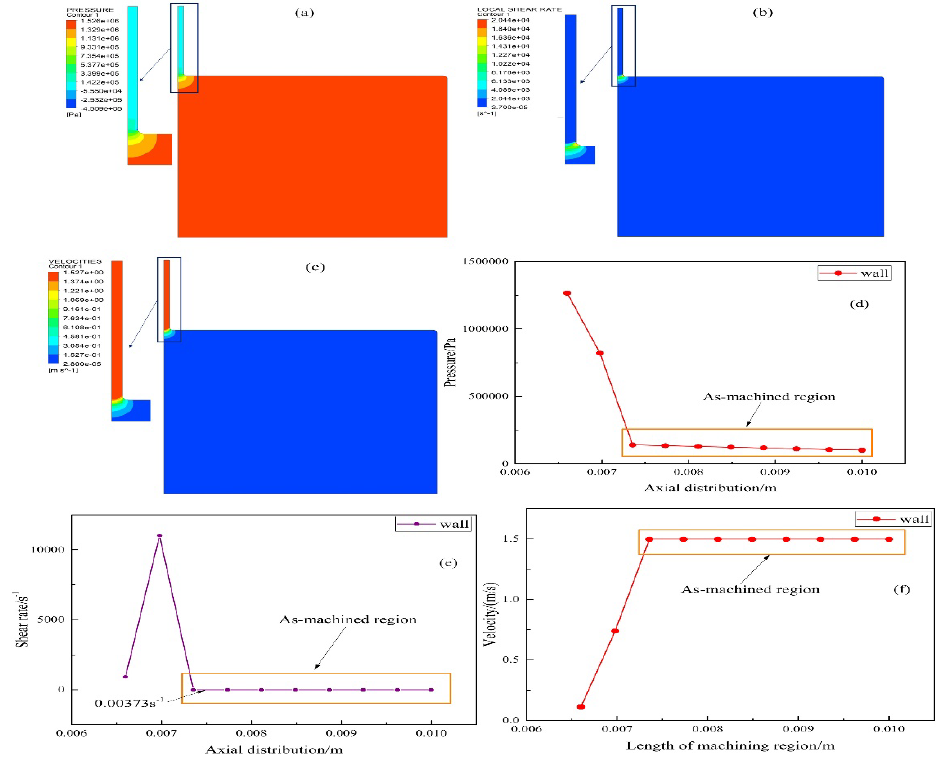
Figure 16. Results of the flow simulation ( a ) pressure distribution, ( b ) shear rate distribution, ( c ) velocity distribution at the fixture region and as-machined region, as well as the ( d ) pressure curve, ( e ) shear rate curve, and ( f ) velocity curve at the wall of the as-machined region [131].